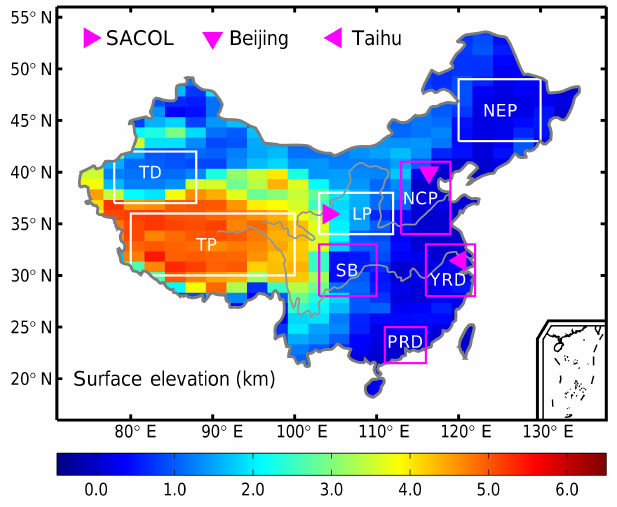
Figure 1. Study regions (square boxes) and AERONET sites (tri- angles) over a 1.0 ◦ × 2.5 ◦ latitude–longitude gridded surface eleva- tion.